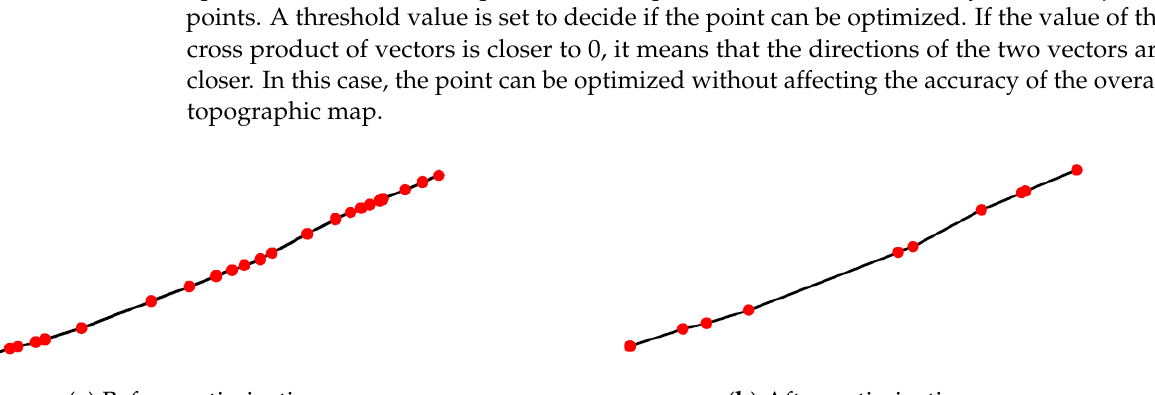
Figure 3. Optimization for a sample of redundant points in the middle of straight lines. Snow track design is a process of gradual refinement from the ski track foundation to the snow path surface. The skeleton is first built and then the contour distance of 5m or 10m for the design of the contour line of the ski track is set. At the same time, the designed contour lines should be as close as possible to the elevation of the original terrain to avoid over-modification of the terrain. The preliminary model of the WTST combined ski track skeleton with contour lines is shown in Figure 4. The designated contour lines highlighted in purple were defined in the process of planning, and the blue contour lines highlighted in blue were defined in the process of calculation.